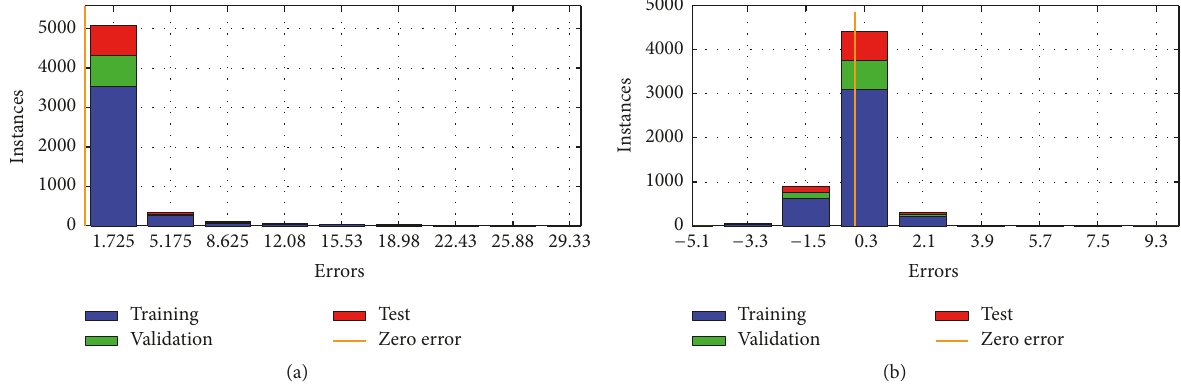
Figure 10: (a) Error diagram of the results from manual feeding for the samples in group 5. (b) Error diagram of predicted result obtained by MSCM-ANN for the samples in group